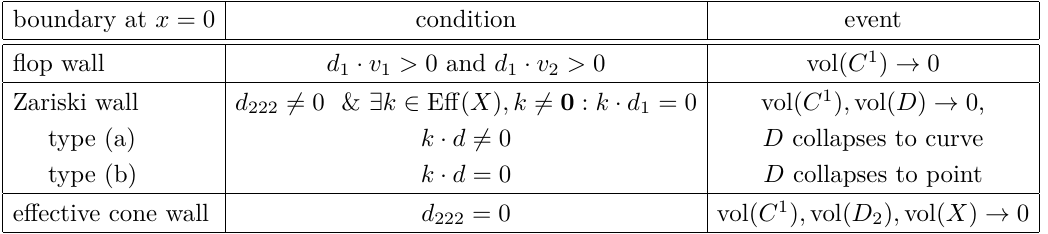
Table 1 . Conditions for possible events at the x = 0 boundary of the Kähler cone. The anal- ogous statements at the y = 0 boundary are obtained by the index exchange 1 ↔ 2 .